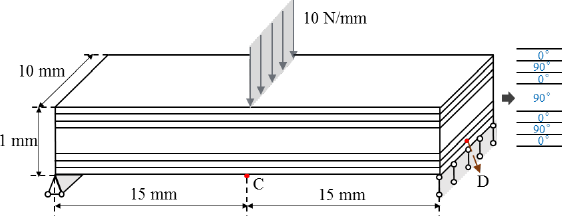
Figure 5: Geometry, lamination, boundary and load conditions of the laminated